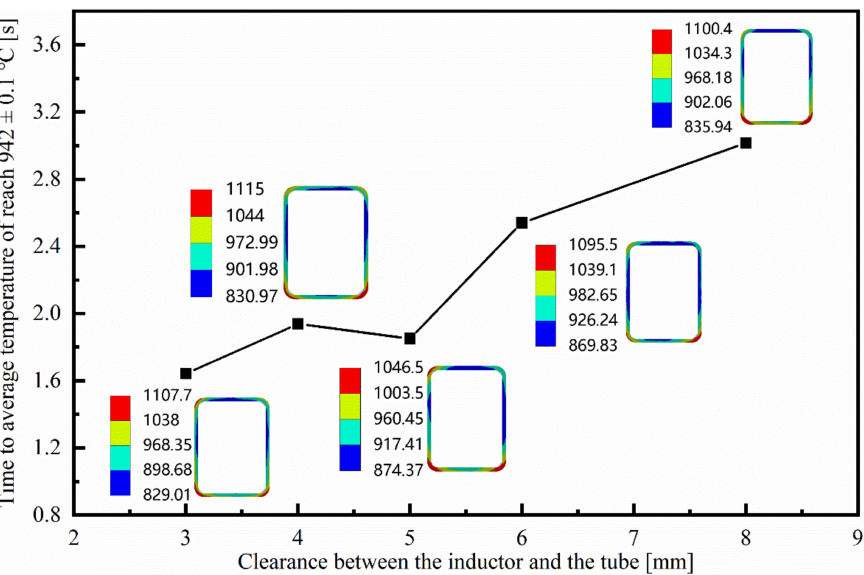
Figure 15. The time taken for the average temperature to reach 942 ± 0.1 ◦ C under different clearances between the inductor and the